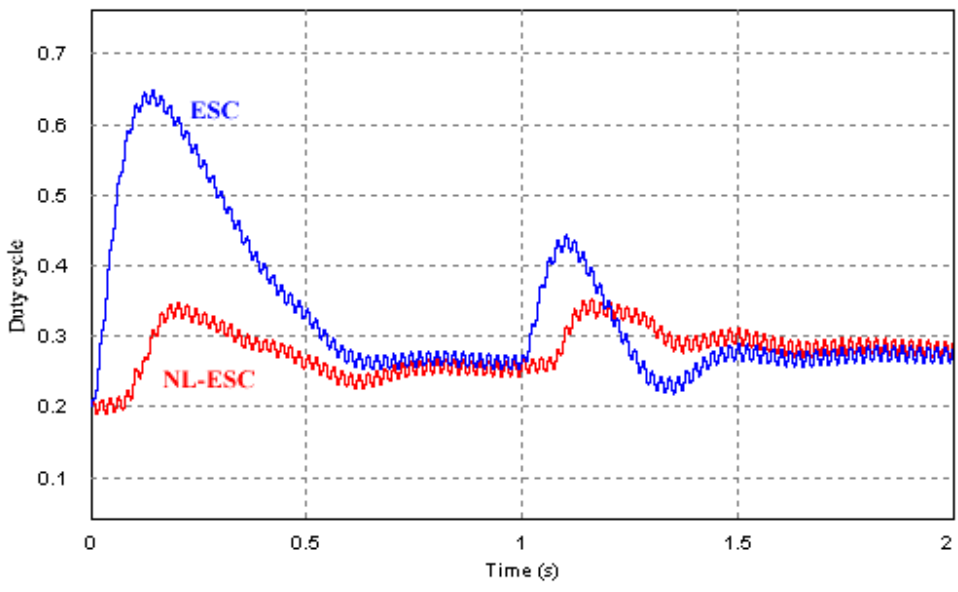
Figure 15. Transient of duty-cycle in front an abrupt irradiance decrease in NL-ESC case ( Red ) and in ESC case ( Blue ).